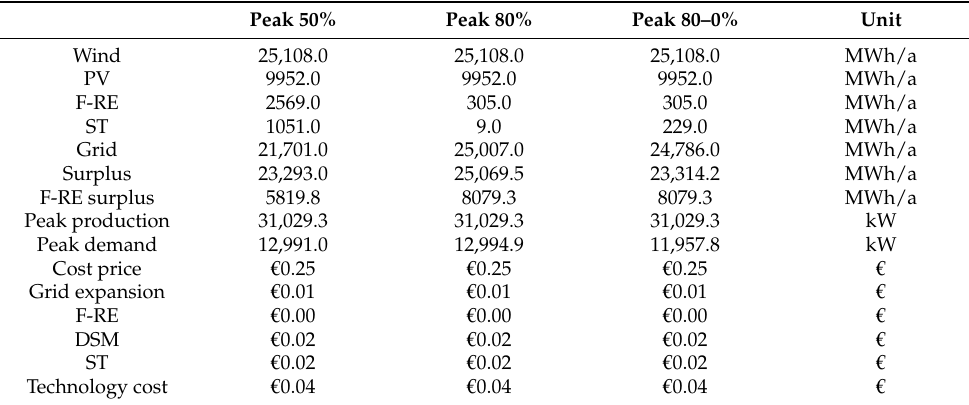
Table A16. Results from the peak